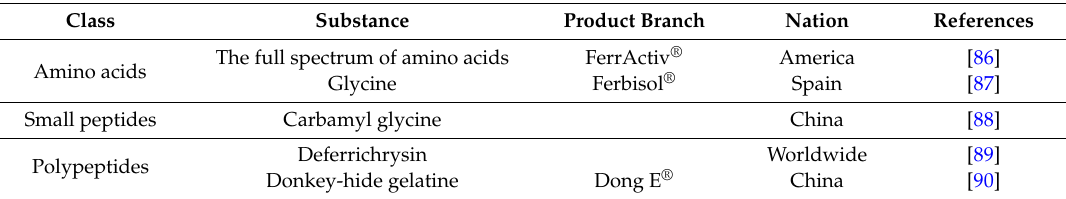
Table 2. The use of peptides or amino acids as iron